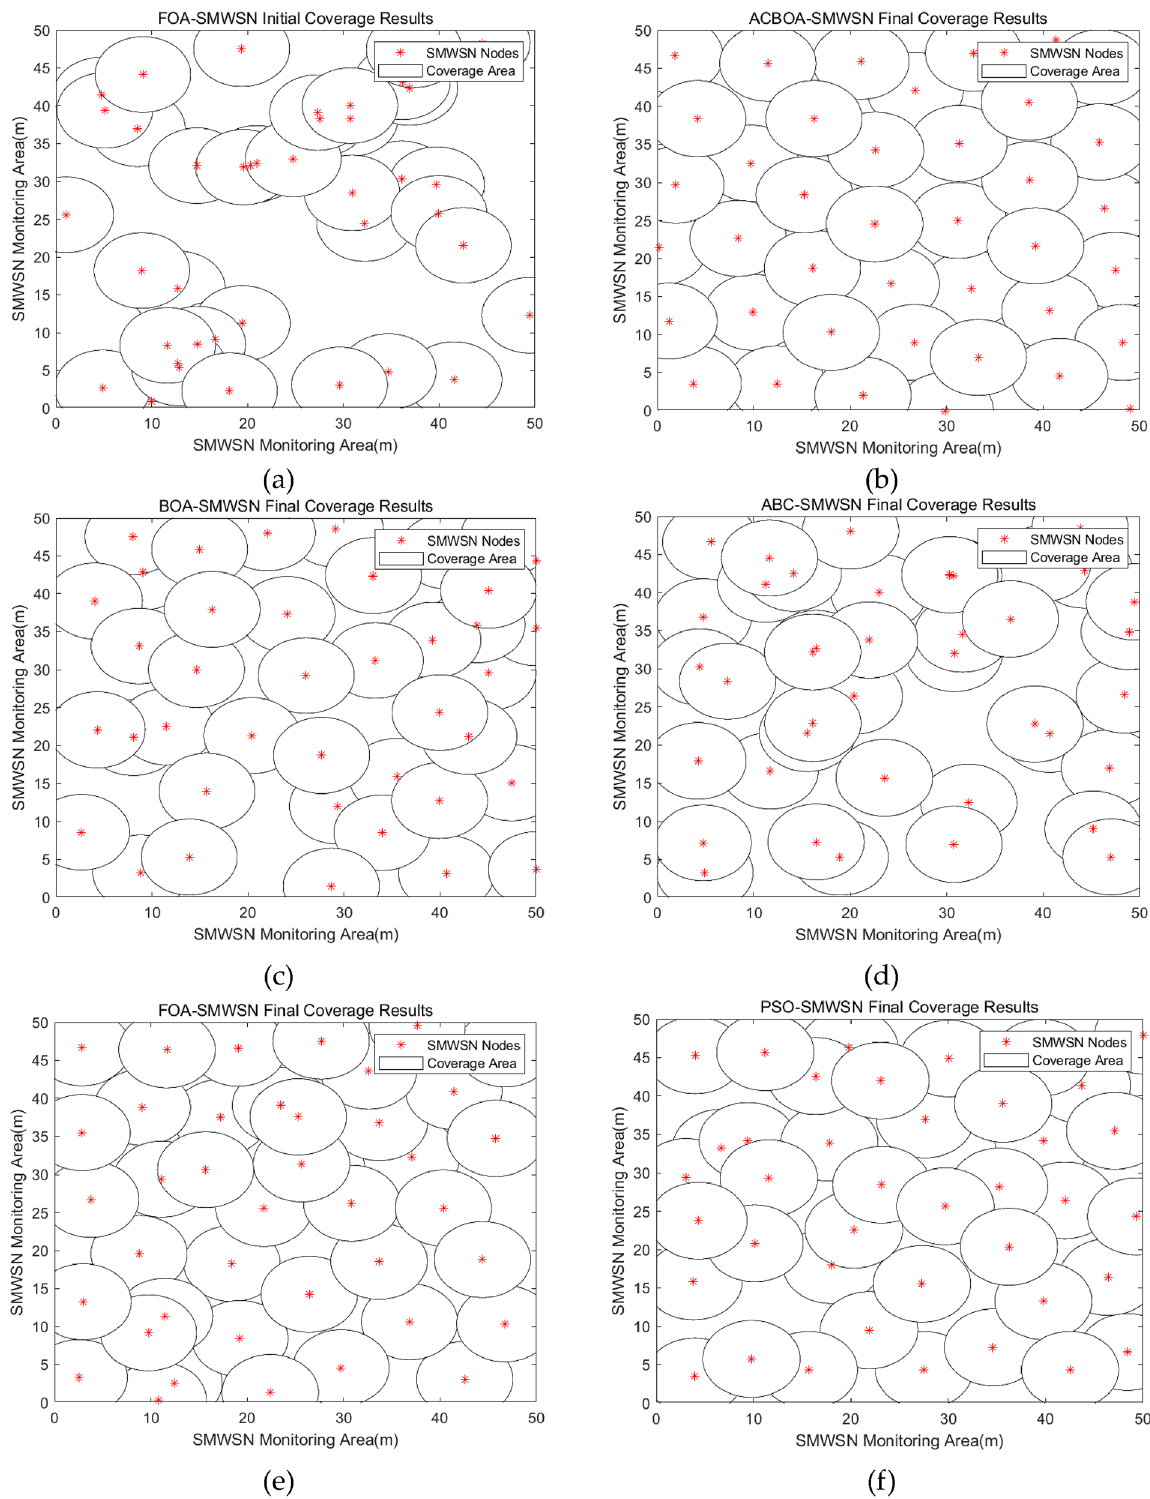
Figure 6. Node deployment when monitoring area 50 m × 50 m, number of nodes 42, sensing radius 5 m, communication radius 10 ± 2 m ( a ) Random deployment, ( b ) ACBOA optimization, ( c ) BOA optimization, ( d ) ABC optimization, ( e ) FOA optimization, ( f ) PSO